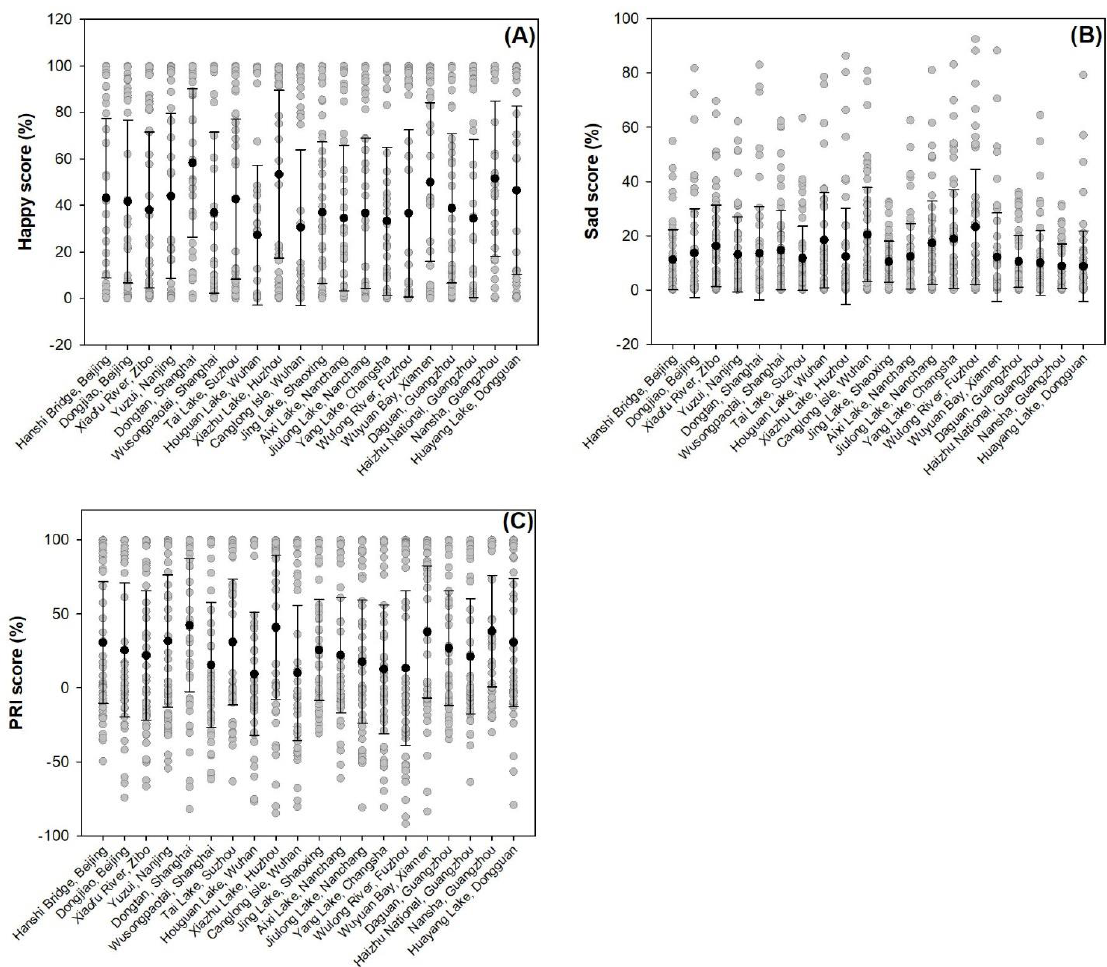
Figure 1. Scattered dots of scores for happy ( A ) and sad ( B ) emotions and positive response index (PRI) ( C ) for people in different urban wetland parks. Scattered dots in light grey indicate original records of raw data. Dots in fully black color present mean values. Whiskers stand for standard errors that are ended by bars of upper and lower limits. All parks are ranked in a latitudinal order from left to right, as in the south to north order.